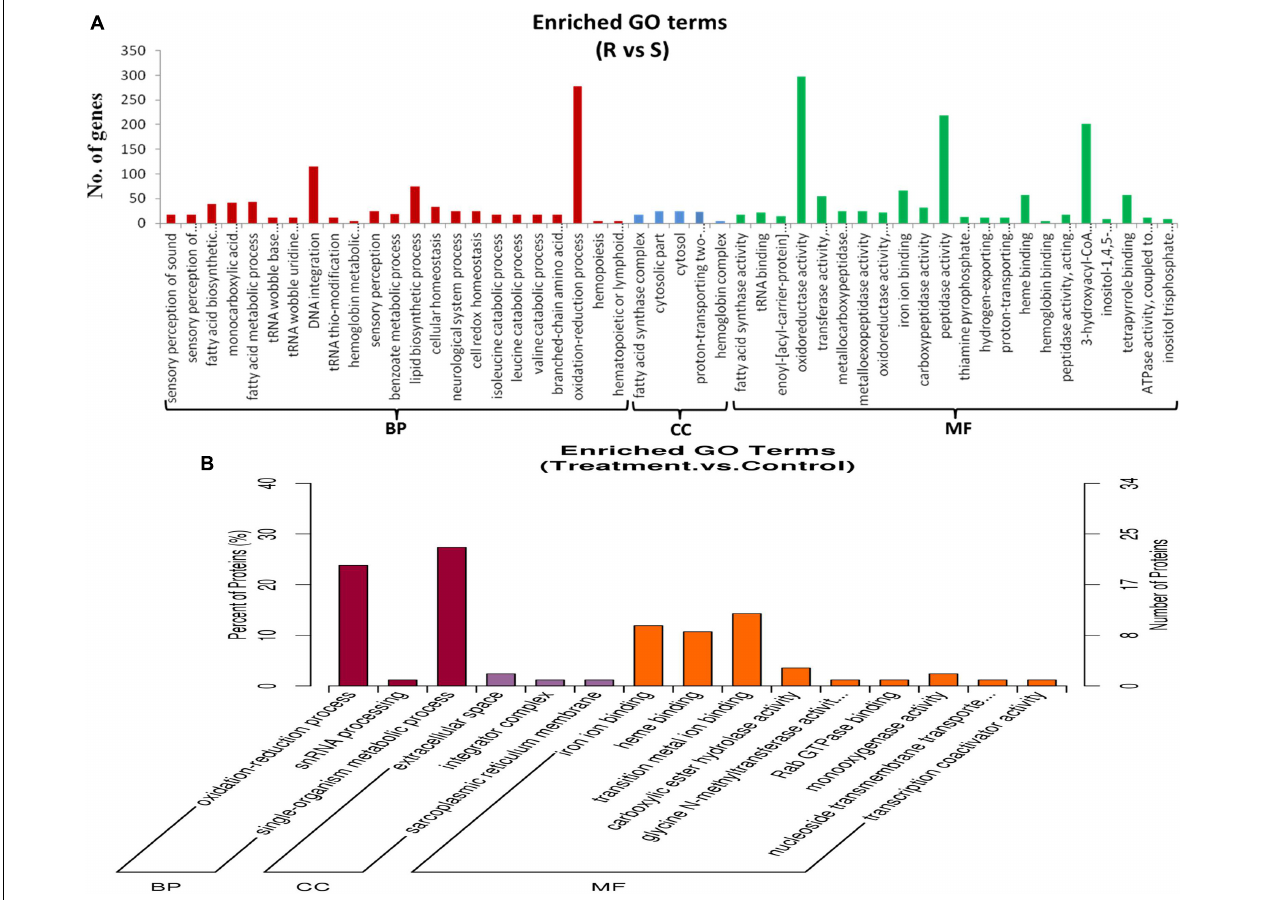
FIGURE 2 | Gene ontological classifications of differentially expressed genes and proteins between ACB-AhR and ACB-BtS. The differentially expressed genes or proteins are grouped into three hierarchically stretched GO terms, biological process, cellular components, and molecular functions. The Y -axis indicates the number of genes or proteins in each GO term. (A) Differentially expressed genes identified by RNA-seq. (B) Differentially expressed proteins identified by